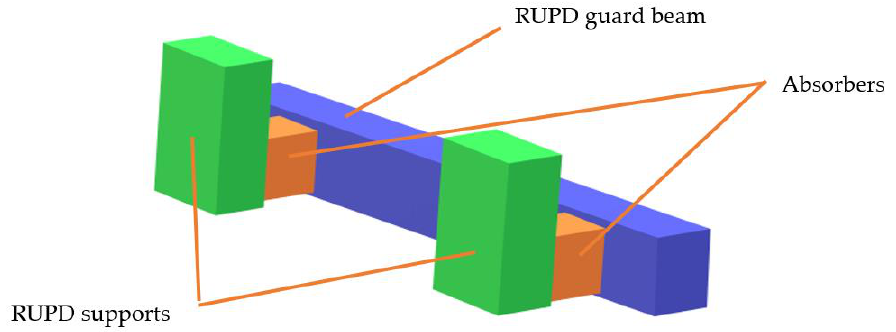
Figure 18. The idea of an impact energy absorbing RUPD.